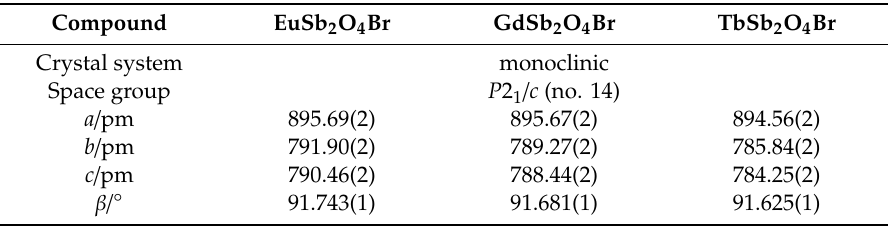
Figure 6. Section of the crystal structure of the Ln Sb 2 O 4 Br series ( Ln = Eu–Tb) viewed along [010] emphasizing the unit-cell edges and [ Ln O 8 ] 13 − polyhedra ( dark red ) utilizing the refined anisotropic displacement parameters with an ellipsoidal probability of 95%. Table 1. Lattice parameters for the three members of the Ln Sb 2 O 4 Br series ( Ln = Eu–Tb) as determined by means of powder X-ray diffractometry.